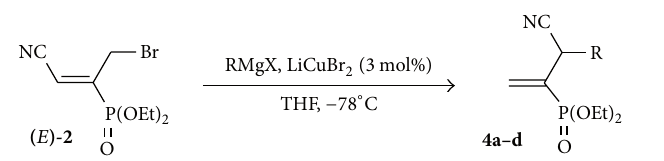
Scheme 4: Conjugate addition of Gilman regents on allyl bromide 2